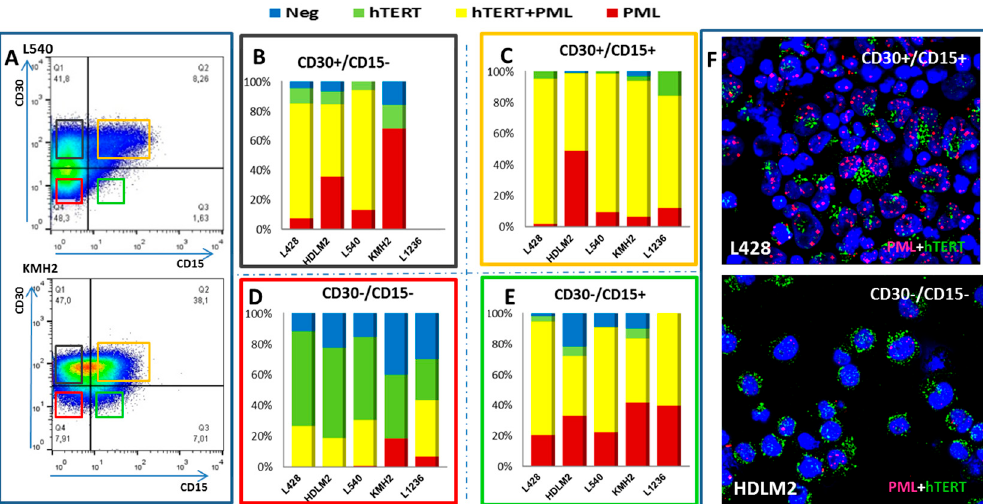
Figure 4. hTERT and PML expression in five HL cell lines according to CD15/CD30 phenotype. ( A ) Four subpopulations from each cell line were sorted according to CD30 and CD15 expression: CD30 − /CD15 − , CD30+/CD15 − , CD30+/CD15+, CD30 − /CD15+; ( B ) hTERT and PML expression in CD30+/CD15 − ; ( C ) in CD30+/CD15+; ( D ) in CD30 − /CD15 − ; and ( E ) in CD30 − /CD15+. Cells without any staining (blue), cells with only hTERT expression (green), cells with PML and hTERT expression (yellow), and cells with only PML expression (red). ( F ) Representative image of CD30+/CD15+ L428 cells and of CD30 − /CD15 − HDLM2 cells showing different types PML and hTER expression (40× magnification).